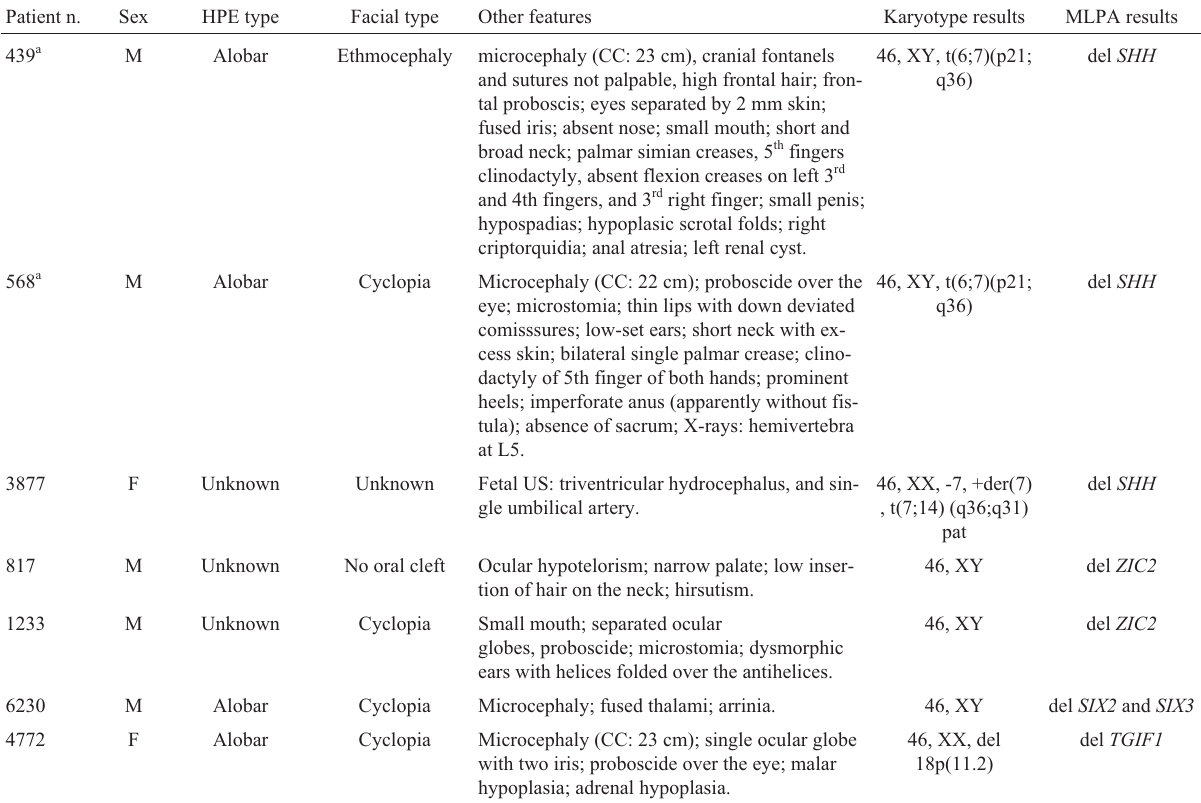
Table 2 - Chromosome deletions in patients with holoprosencephaly (HPE). Patient